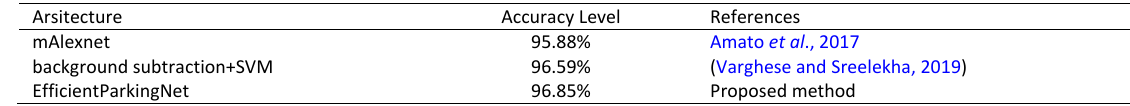
Table 5: Comparison of CNRPark+EXT test classifications